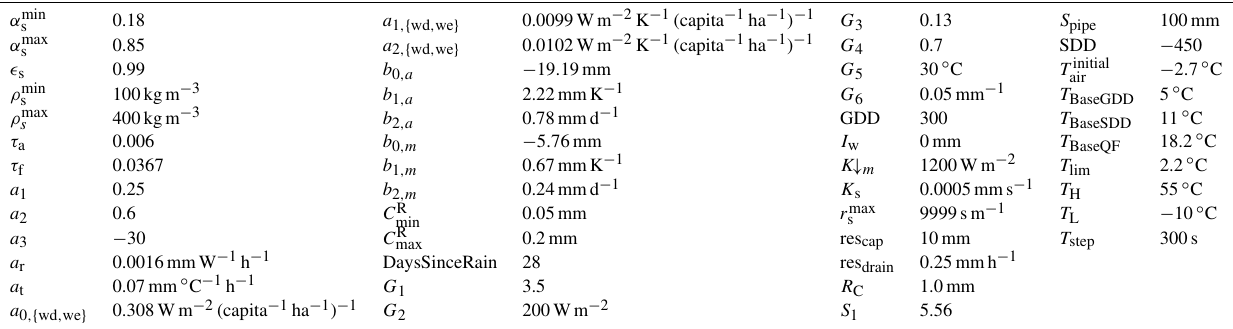
Table 1. Overall model parameter values used in model runs in Beijing. See Table A1 in the Appendix for notation and Järvi et al. (2011, 2014) and Ward et al. (2016) for data